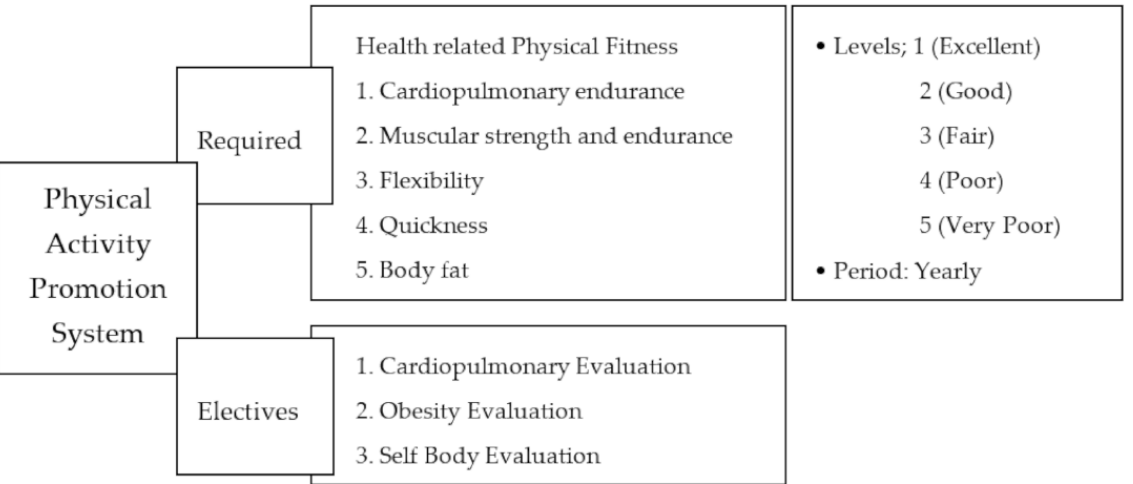
Figure 1. Schematic Diagram of Physical Activity Promotion System